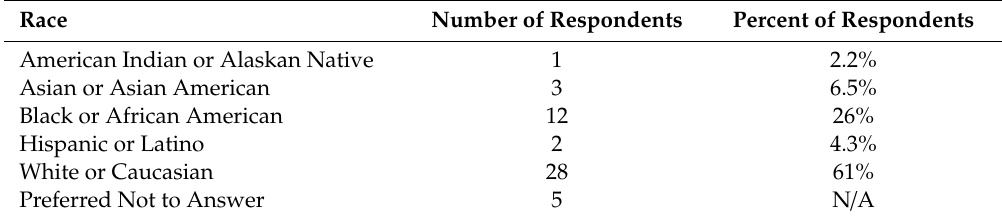
Table A1. Demographic data of participants. Race of participants.